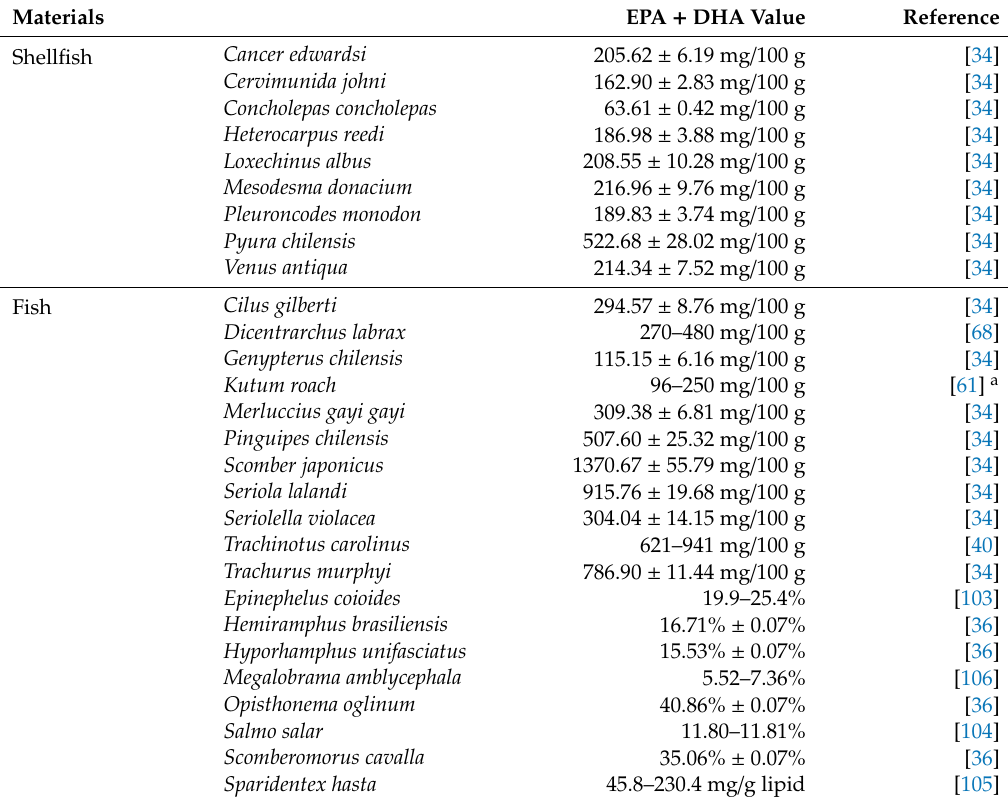
Table 8. Application of EPA + DHA in fatty acid evaluation *.